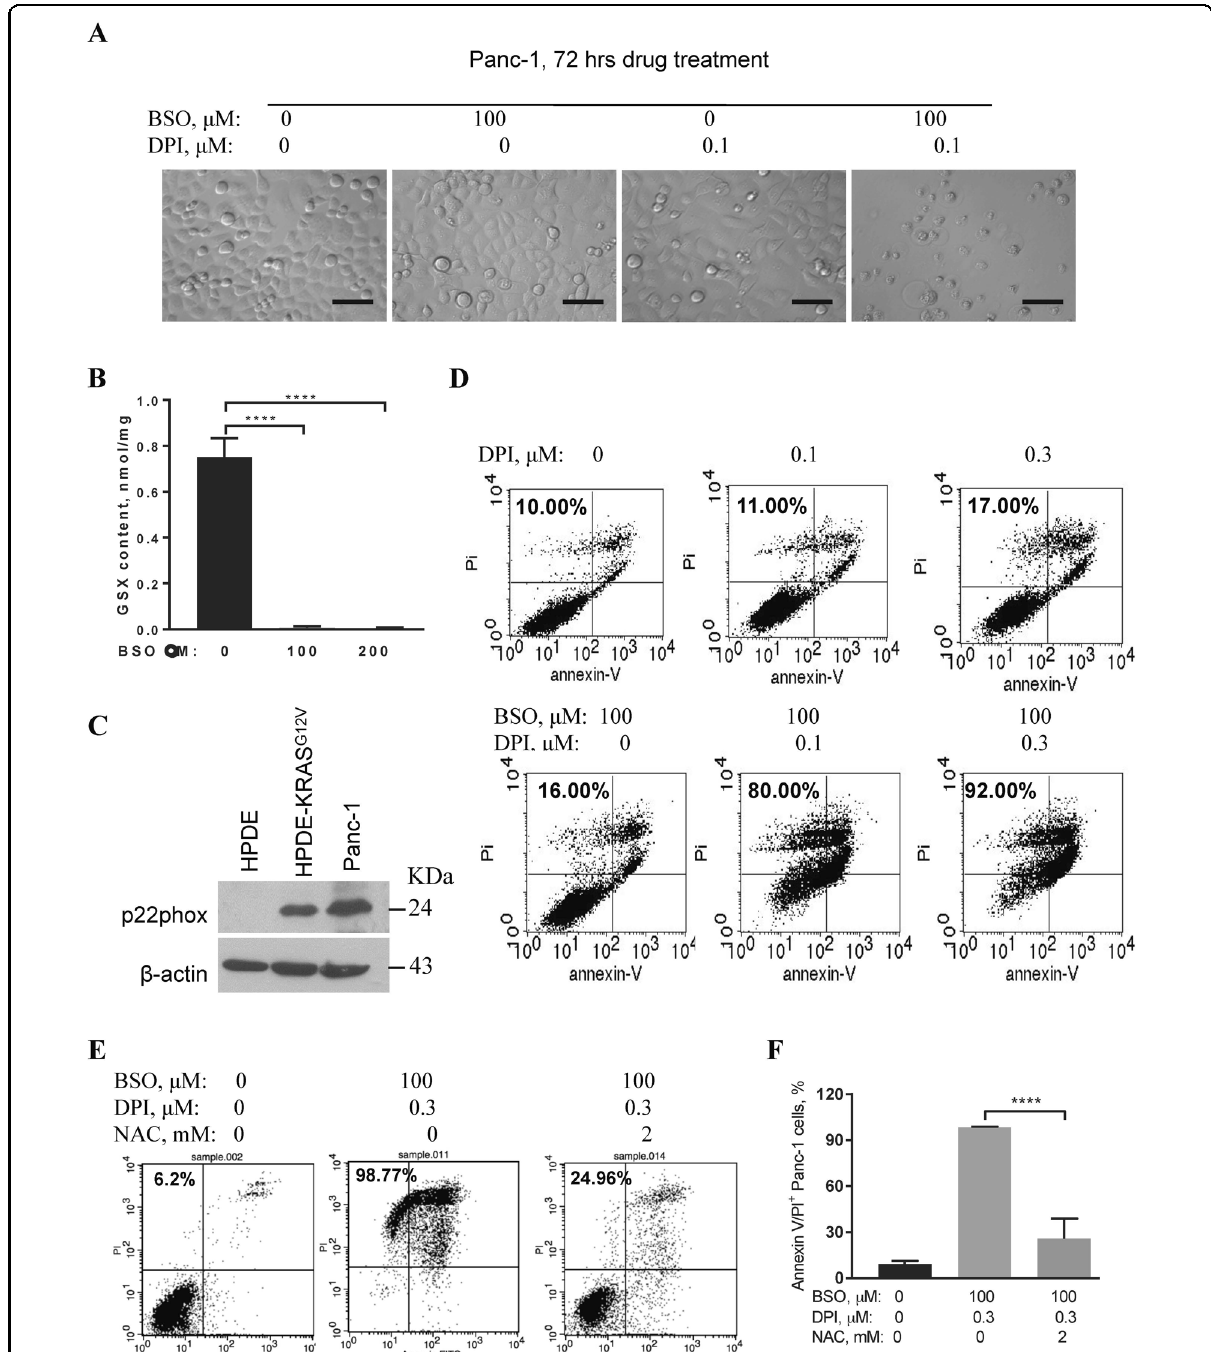
Fig. 4 BSO and DPI cooperatively induce signi fi cant death of primary human pancreatic cancer cells. A Comparison of cell morphology and growth in Panc-1 cells after treatment with 0.1 μ M DPI, 100 μ M BSO, or the combined 100 μ M BSO and 0.1 μ M DPI for 72h. DPI or BSO treatment alone had a limited impact on Panc-1 cells, while the combined treatment considerably reduced the number of living cells as observed under a light microscope. Scale bar, 200 μ m. B Total cellular glutathione (GSX) levels were measured by spectrophotometry after 24h of BSO treatment at 0, 100, or 200 μ M in Panc-1 cells. Treatment was performed with three independent experiments. C Western blot analysis of p22phox protein levels in Panc-1 cells and oncogenic KRAS G12V -transformed HPDE cells as compared to parental HPDE cells. KDa, kilodalton. D Concurrent DPI and BSO treatment induced signi fi cant Panc-1 cell death. Cells were incubated with 0.1 or 0.3 μ M DPI, 100 μ M BSO, or their combination as indicated for 72h, and cell death was determined by Annexin V/PI double staining. Panc-1 cells without any treatment served as the control. E Panc-1 cells were treated with 0.3 μ M DPI and 100 μ M BSO combination in the presence or absence of 2mM NAC for 72h. Cell death rates were determined by Annexin V/PI double staining. F Statistical analysis of the percent death rates of Panc-1 cells treated in E . Data are mean±SD of three independent experiments with Student ’ s t test. **** p <0.0001. Of fi cial journal of the Cell Death Differentiation